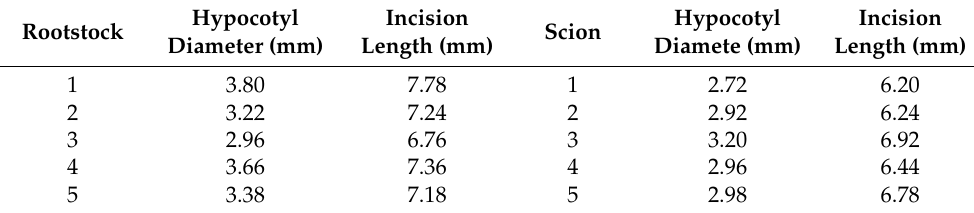
Table 3. Cutting test data.